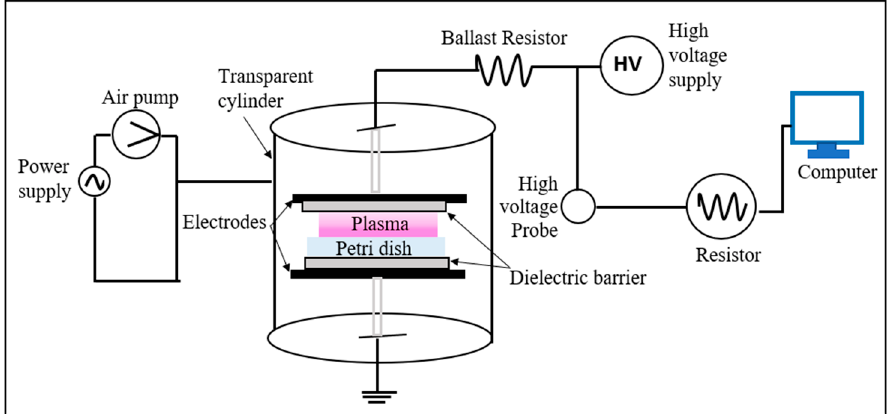
Figure 1. Experimental setup. Schematic diagram of the DBD reactor. A DBD was generated between the two planar copper electrodes at a 0.2 cm distance (Figure 2). Round electrodes with a 5 cm radius and 0.2 mm thickness were used, which were covered with alumina dielectric layers ( ε r = 10) of 0.1 cm in thickness [33].